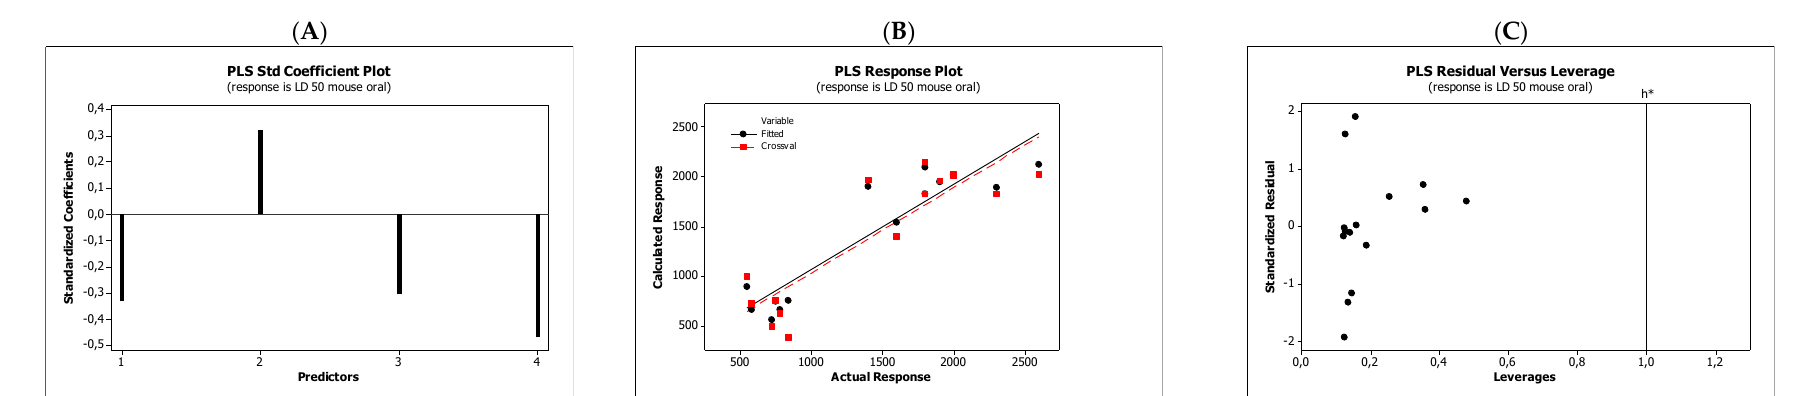
Figure 12. Standardized coefficients ( A ), the correlation between actual and predicted LD 50 mouse oral parameters ( B ), and the Williams plots ( C ) of Equation (11).